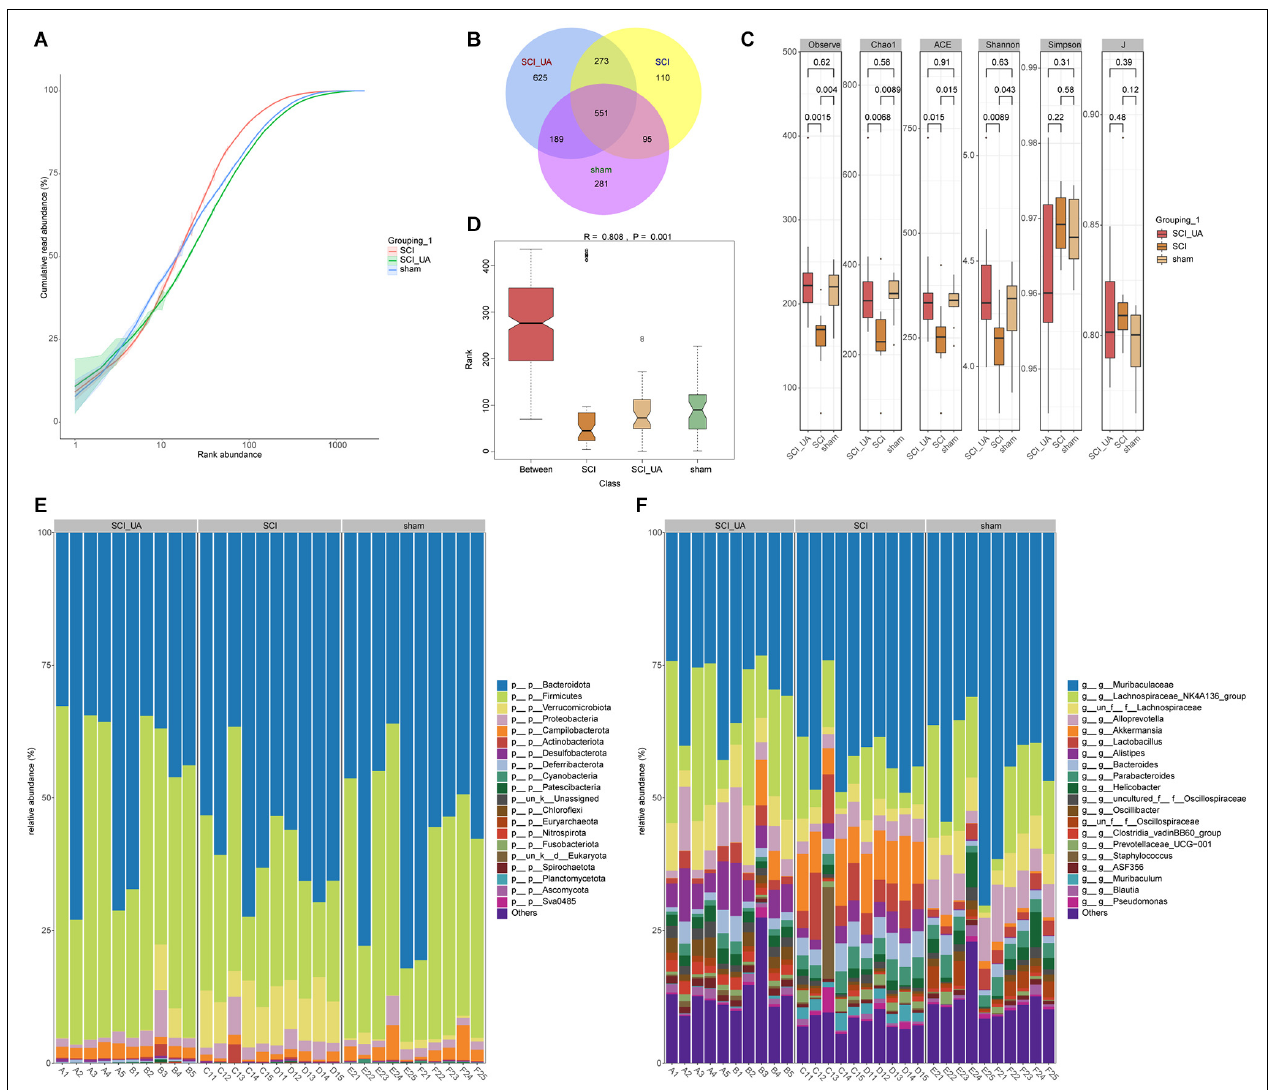
FIGURE 3 | UA improved gut microbiota diversity in SCI mice. (A) The cumulative read abundance of gut microbiota in mice. (B) Venn diagrams showed the number of gut microbes in different groups. (C) Alpha diversity was calculated. (D) Anosim was used to analyze the significance of differences between groups.